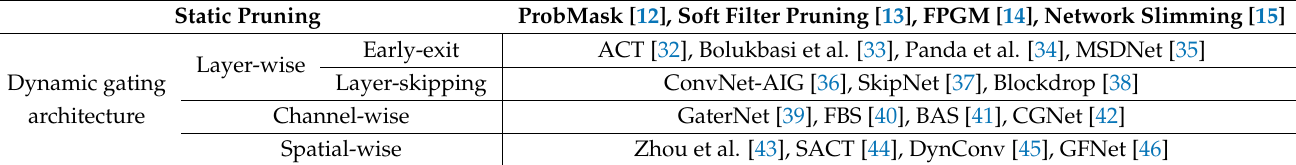
Table 1. Summary table for computation-efficient CNN